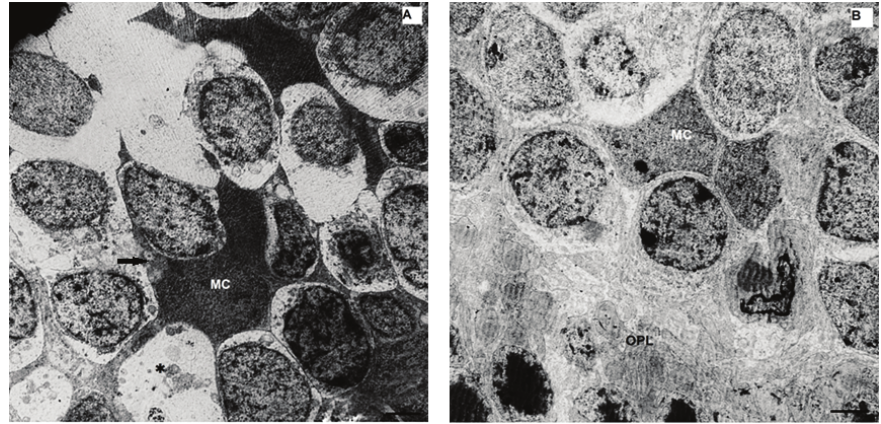
Figure 4. Electron micrographs of the inner nuclear layer (INL) in group D (A) and group DG (B). (A) An apoptotic Müller cell (MC) with highly condensed chromatin, membrane swelling, ruptured mitochondria (arrow), and numerous empty spaces (asterisk) containing membranous debris due to cell death. (B) Well-preserved microvilli of Müller cells (MC); OPL, outer plexiform layer (Scale bar, 2